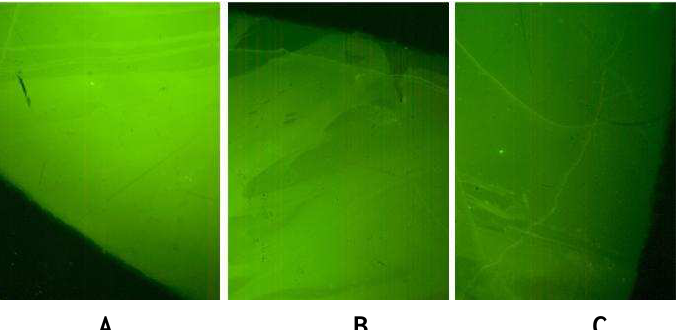
Figure 3 : A) Fluorescence of the chip surface after the binding of the labelled ss DNA; B) after the overnight dialysis in HEPES solution; C) after the overnight dialysis in deionised water.